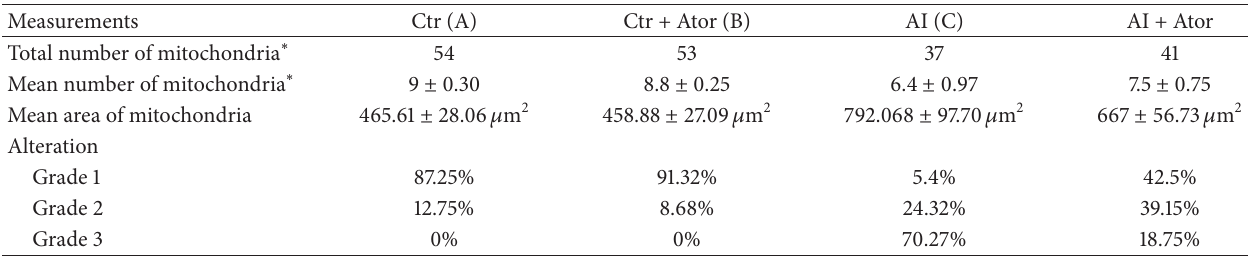
Table 1: Mitochondrial quantifications in the smooth muscle of the thoracic aorta of rats with atherogenesis induced by hyperfibrinogenemia and treated with atorvastatin.